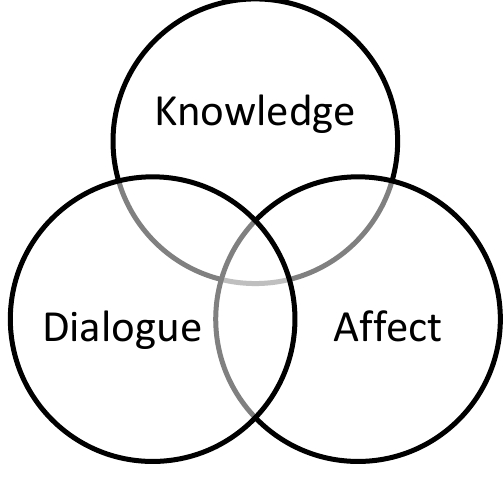
Figure 5. Knowledge, affect, and dialogue: Foci of online